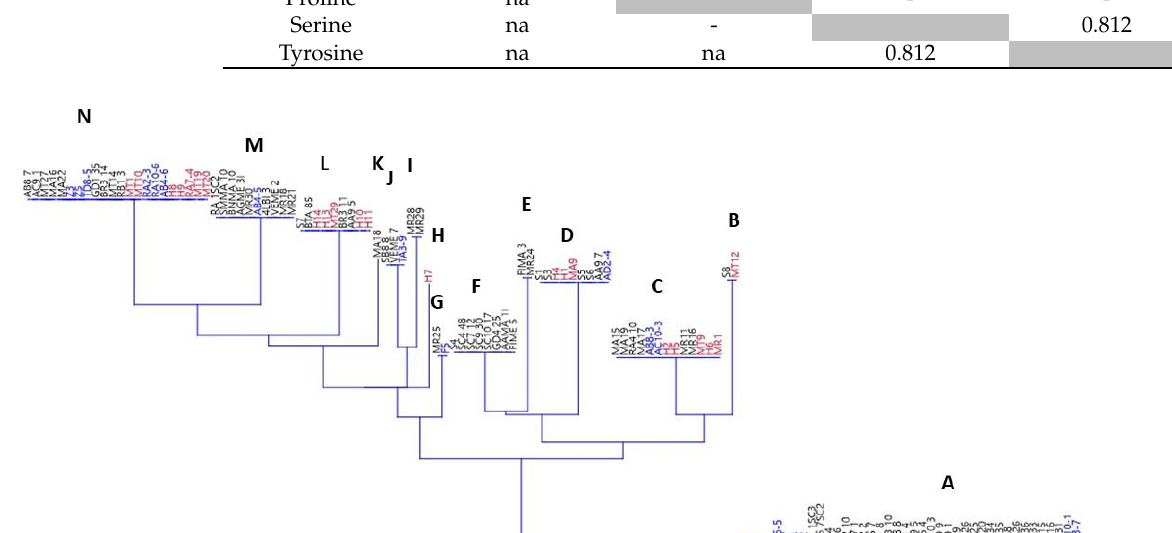
0.812 Serine and tyrosine decarboxylation responses were always related, with correlation coefficients of 0.780 in S. cerevisiae , 0.816 for Z. bailii and 0.812 in Hanseniaspora spp.; more- over, other correlations were also found in the case of Z. bailii between serine and proline (0.806), a partial correlation between proline and arginine (0.611), or between arginine and tyrosine (0.612).